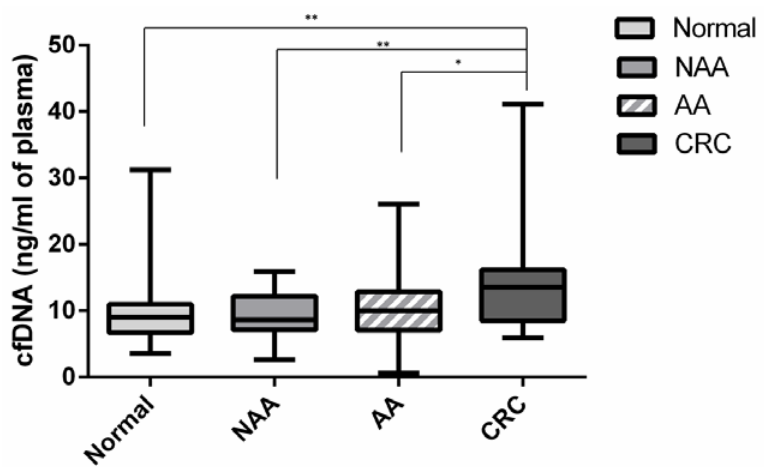
Figure 2. Box plots for the distribution of circulating free DNA concentrations in each group by QuantiFluor ® . Each box indicates the 25th and 75th percentiles. The horizontal line inside the box indicates the median and the whiskers the extreme measured values. The Mann–Whitney test was performed for determination of statistical significance. * p < 0.05; ** p < 0.01. Normal: no lesion group; NAA: non-advanced adenoma group; AA: advanced adenoma group; CRC: colorectal cancer group.